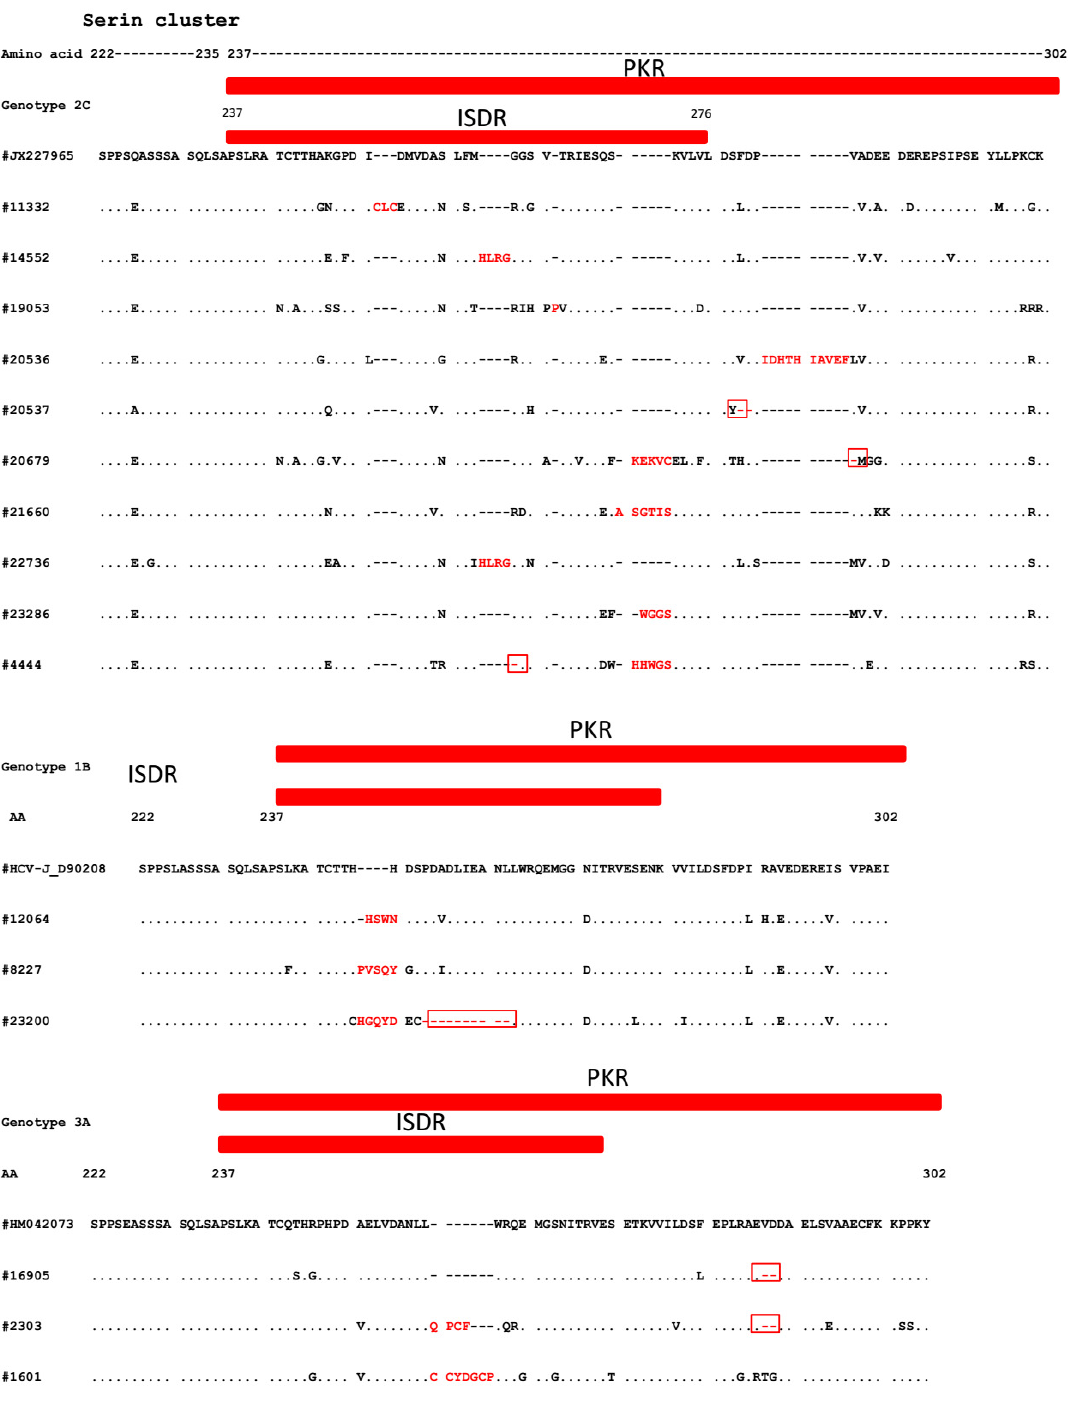
Figure 2. Sequence alignments of hepatitis C virus (HCV) with insertions/deletions in interferon sensitivity-determining region (ISDR) and direct-acting antiviral drugs (PKR-bd). Aminoacid insertions are in red (bold) and deletions are within red boxes.